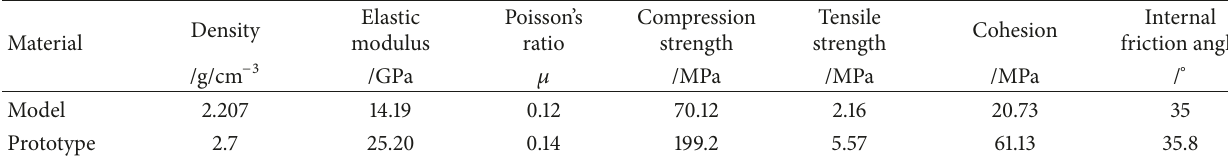
Table 1: Physical-mechanical properties of silicon powder mortar and marble.